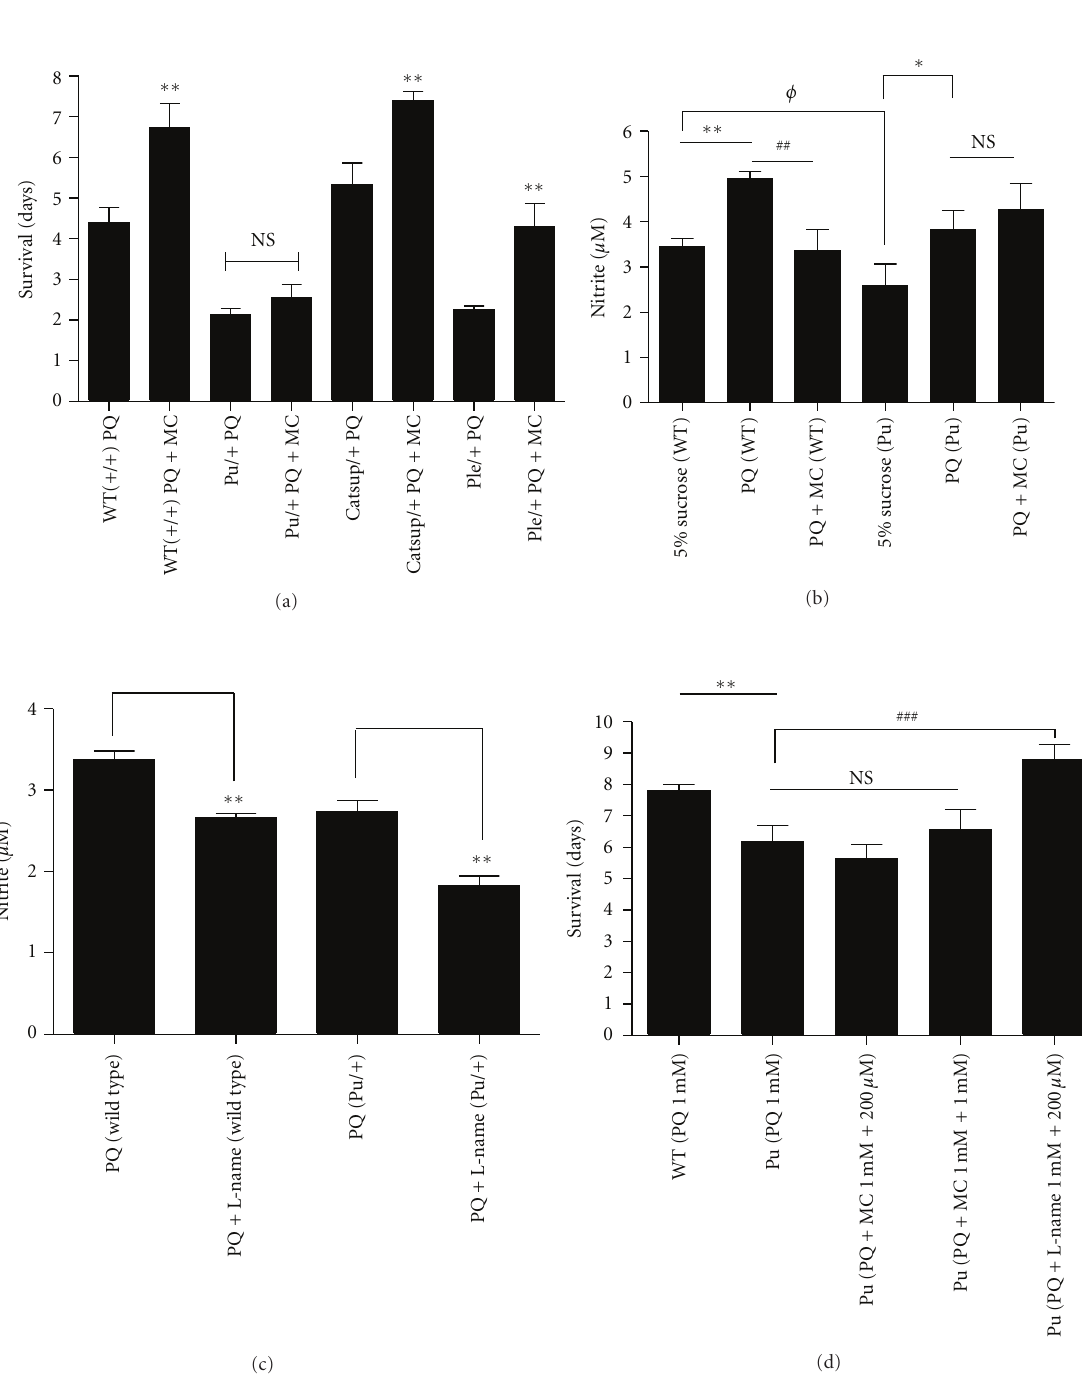
Figure 6: MC fails to rescue Punch mutants due to dysregulation of nitric oxide synthase catalytic function. (a) E ff ect of 1mM MC co-fed with 10 mM PQ on DA regulatory mutants, Catsup 26 / +, Pu Z 22 / + and ple 2 / +. Catsup and ple mutant flies showed extension of life span, while Pu mutants did not. NS = not significant. ∗∗ = P < 0 . 005 and represents significant di ff erences between PQ and PQ with MC. (b) After 24hr of PQ, or PQ with MC exposure, suppression of NOS was detected in wild type heads but not in Punch mutants where NO levels of non-PQ-treated Pu mutants assayed are significantly lower than NO levels of non-PQ-treated wild type heads. ∗ or φ P = < 0 . 05 and ∗∗ or ## P = < 0 . 005. (c) Co-feeding of L-NAME with 1mM PQ reduced NO production in wild type and Pu mutants. ∗∗ = P < 0 . 005. (d) The survival of Pu mutants was improved by co-feeding PQ with L-NAME, but not with MC when compared with survival of Pu mutants on PQ alone. ∗ represents significant di ff erences between control and PQ-exposed flies, while # represents significant di ff erences between flies fed PQ only and PQ with MC. ∗∗ = P < 0 . 005 and ### = P < 0 . 001. NS = not significant. Error bars represent standard error of the mean and n = 100–120 fly heads for NOS assays and 50–60 flies for survival where experiments were replicated thrice with the same sample